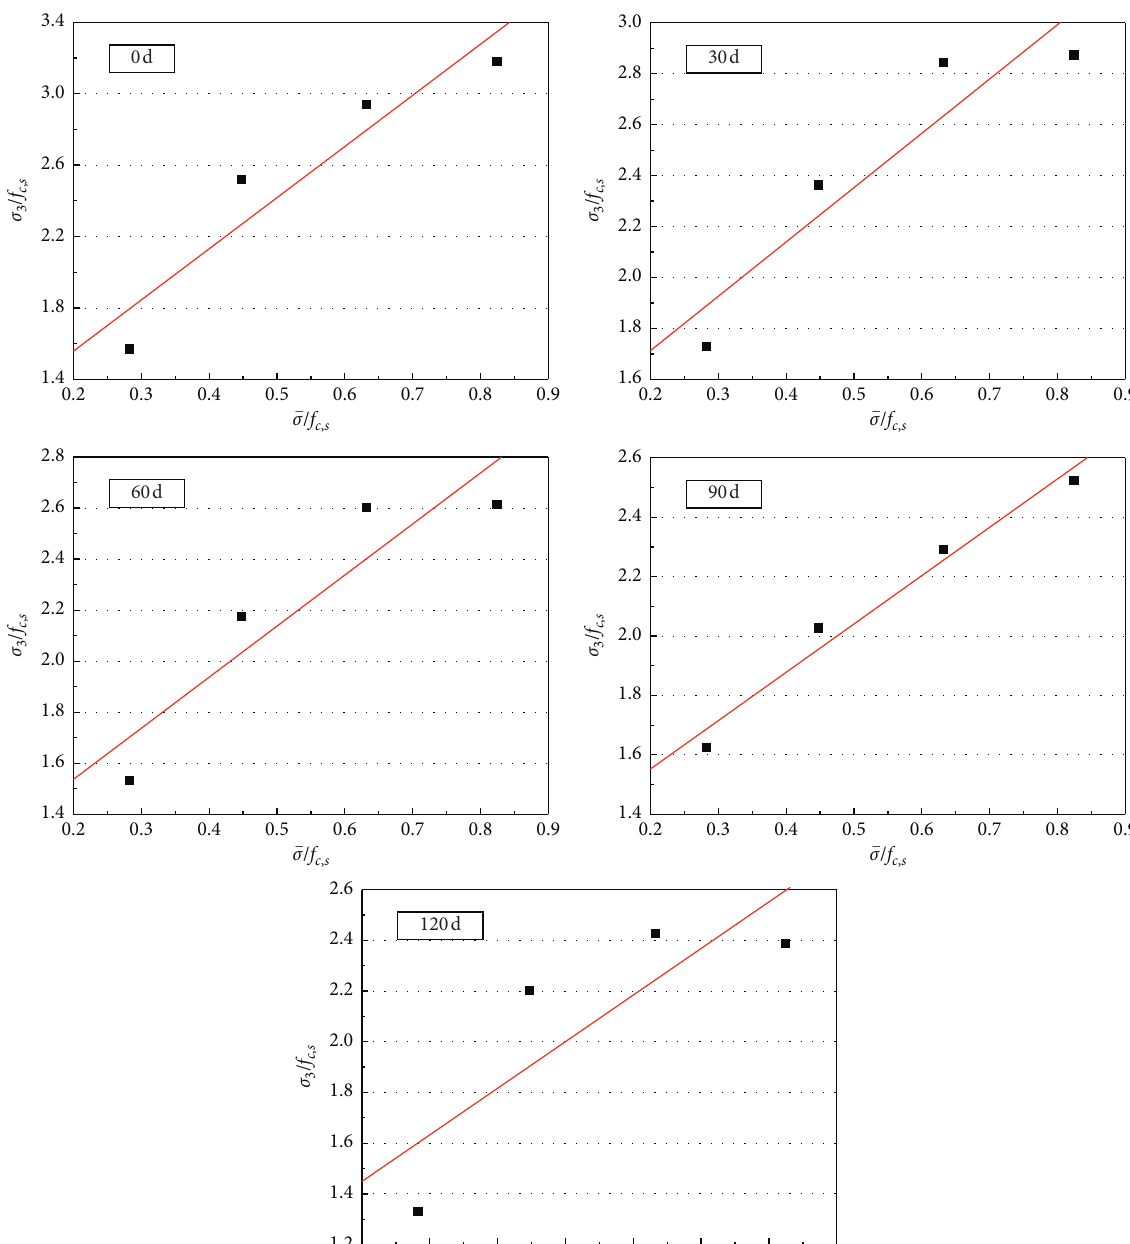
Figure 13: Fitting curve of triaxial static compressive strength of